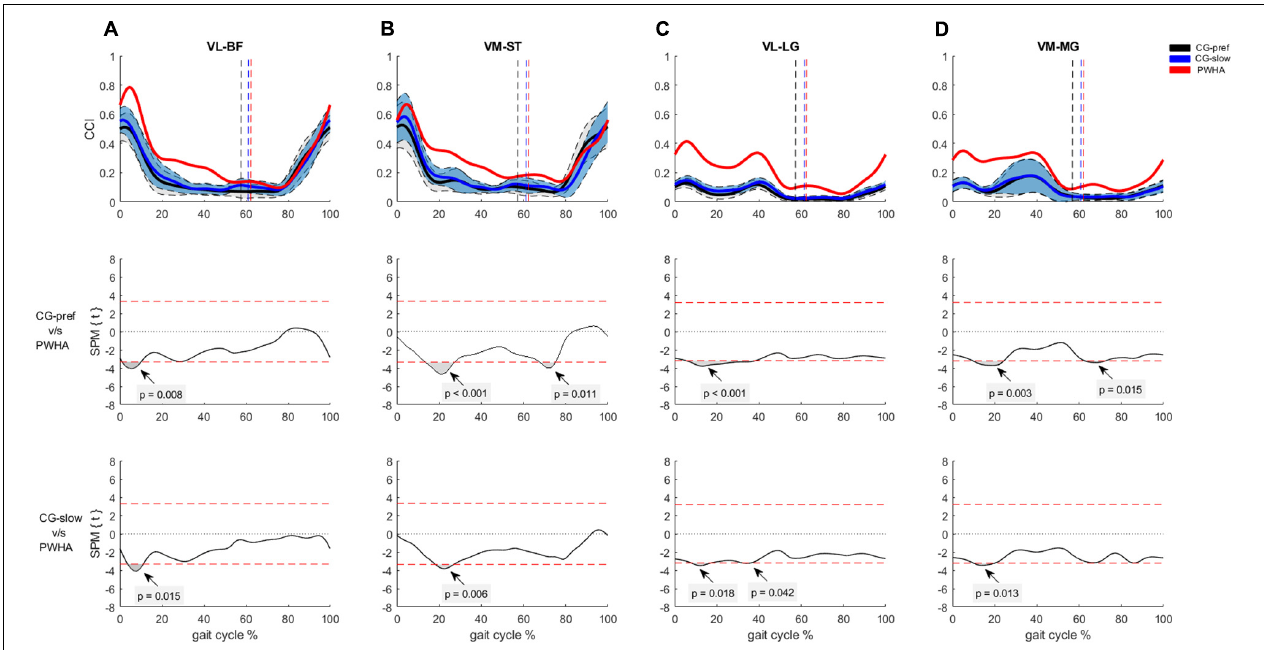
FIGURE 6 | Co-contraction of muscles crossing the ankle during gait. (A) Con-contraction index (CCI) between vastus lateralis and biceps femoris (VL-BF). (B) CCI between vastus medialis and semitendinosus (VM-ST). (C) CCI between vastus lateralis and lateral gastrocnemius (VL-LG). (D) CCI between vastus medialis and medial gastrocnemius (VM-ST). (Top row) CCI of muscles crossing the knee of people with hemophilic arthropathy (PWHA; n = 14) at their preferred velocity (red), the control group ( n = 13) at their preferred velocity (CG-pref, black), and during the slow velocity condition (CG-slow, blue). Data are plotted as a function of normalized step time (0, heel strike) and expressed as mean with 95% confidence interval for CG. Vertical dashed lines indicate transition from stance to swing phase (black, CG-pref; blue, CG-slow; red, PWHA). (Bottom two rows) Time-dependent t values of the statistical parametric mapping (SPM) for groups comparison. Horizontal red dashed line indicates p = 0.05 level. Gray zones indicate regions with statistically significant differences. a.u, Arbitrary